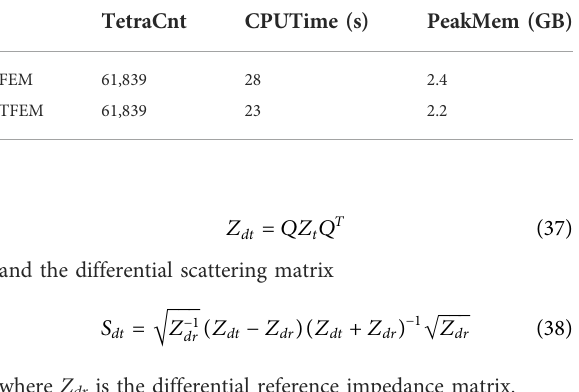
TABLE 1 Comparison of computational ef fi ciency between FEM and